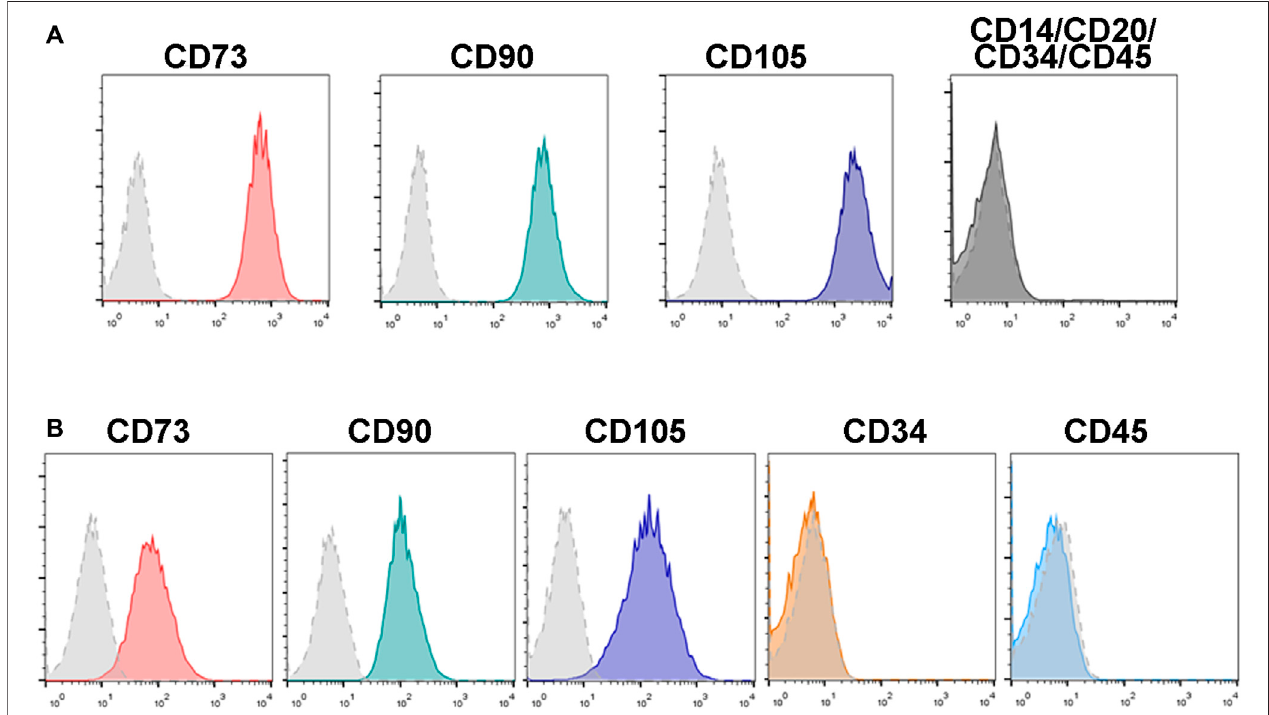
FIGURE 2 | Immunophenotypical analysis of human and mouse BM-MSCs. MSCs isolated from human (A) and mouse (B) bone marrow express typical MSC markers such as CD73, CD90 and CD105, whereas expression of the hematopoietic markers CD14, CD20, CD34, and CD45 are low or negative. Control isotype antibodies staining are shown as dotted light grey histograms. Histograms show representative fl ow cytometry results obtained from n (cid:2) 3 separate human and mouse BM-MSC samples.